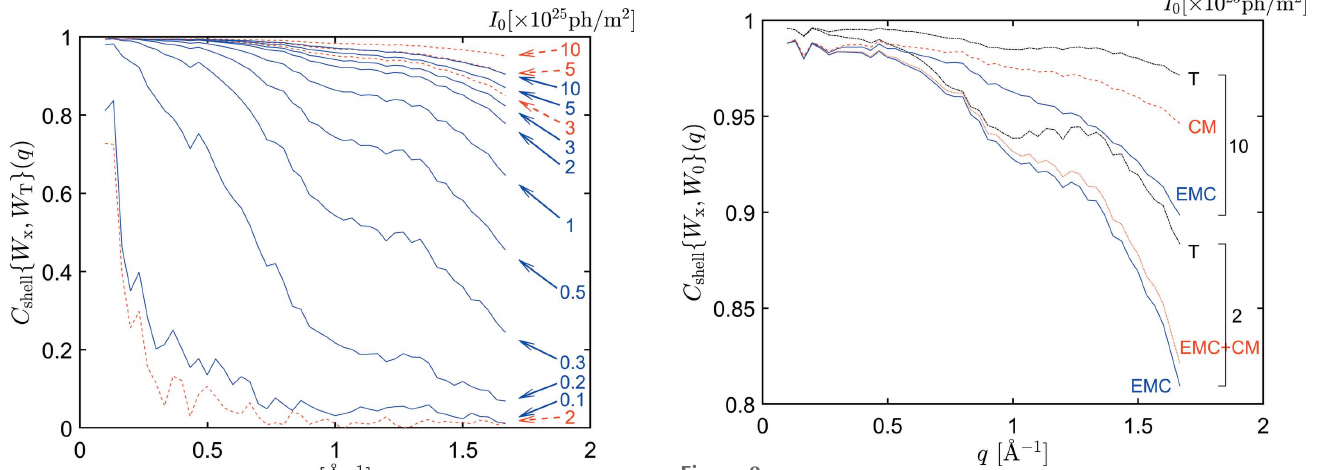
Figure 8 FSC between the 3D intensity volume W reconstructed by the EMC (blue solid lines) method, the CM (red dashed lines) method or a combination of both methods (red dotted line), and using the true orientations ( W T , black dash-dotted line) and the noiseless model intensity W 0 , at I 0 = 2 (cid:3) 10 25 and 10 26 for RNA polymerase II.